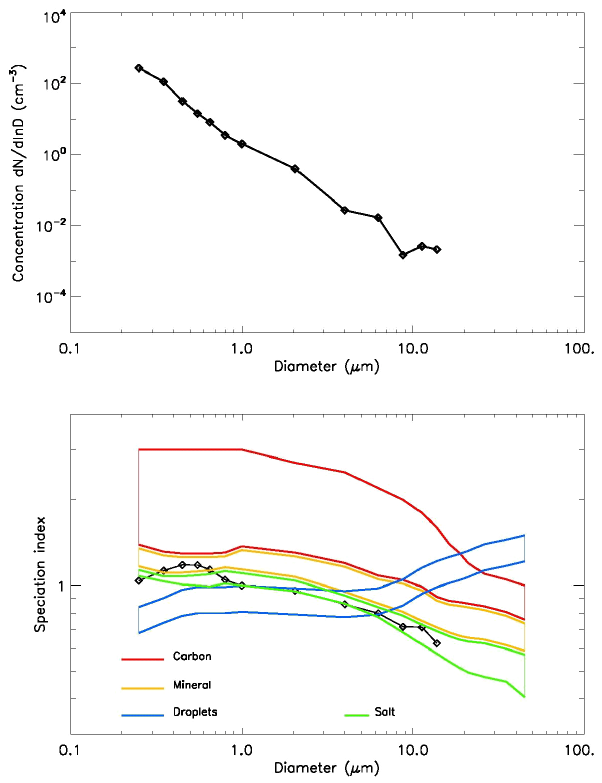
Figure 19. Example of measurements inside a cloud at Puy de Dôme observatory (France) on 15 May 2013 at 10:30UT; upper panel: size distribution; lower panel: typology, the LOAC data are in black dots. The LOAC uncertainties are ± 20% for the higher concentrations and ± 60% for the lower